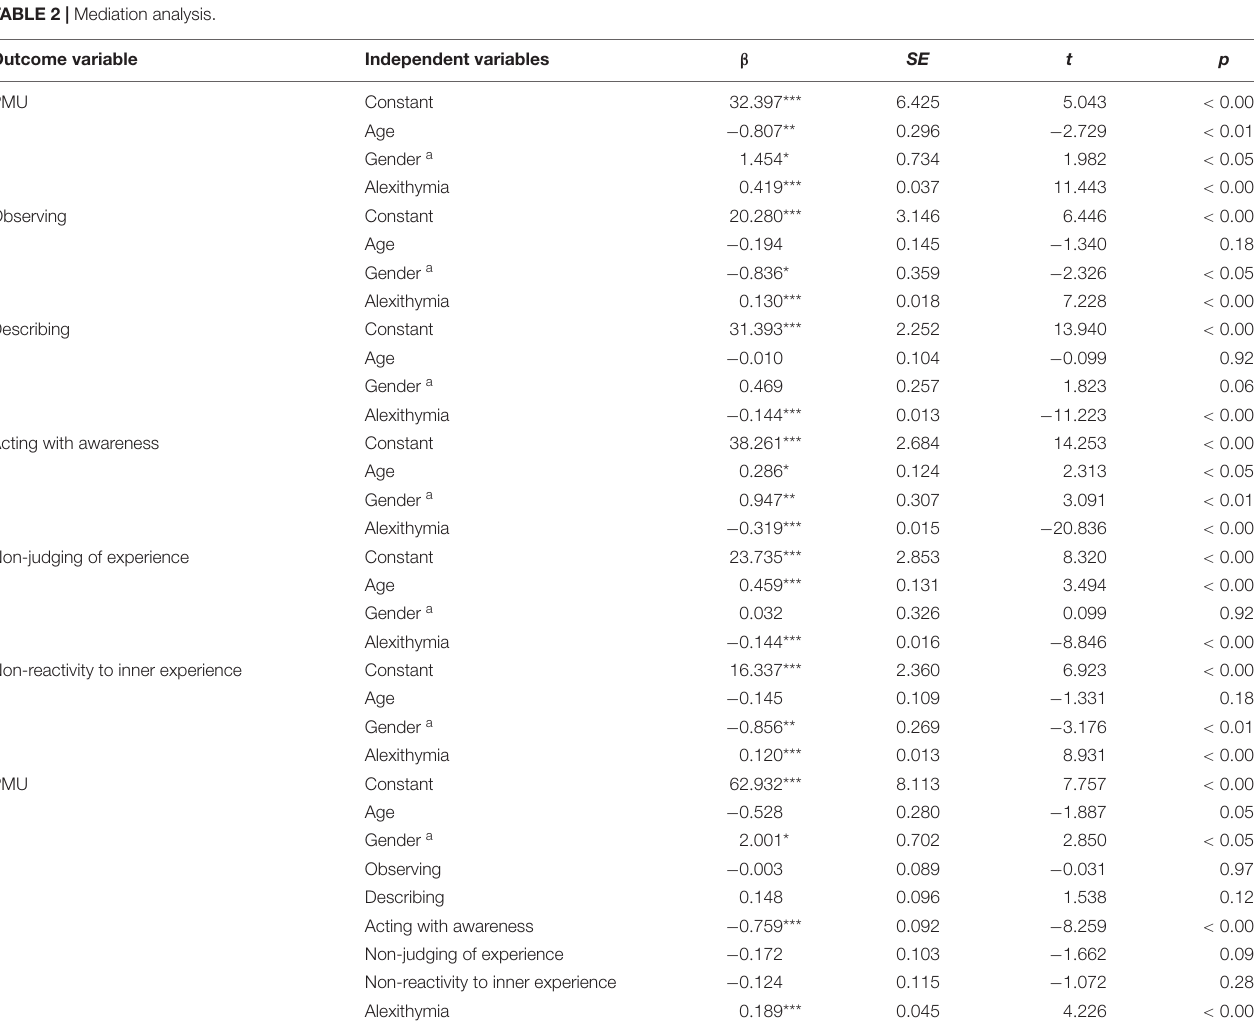
TABLE 2 | Mediation